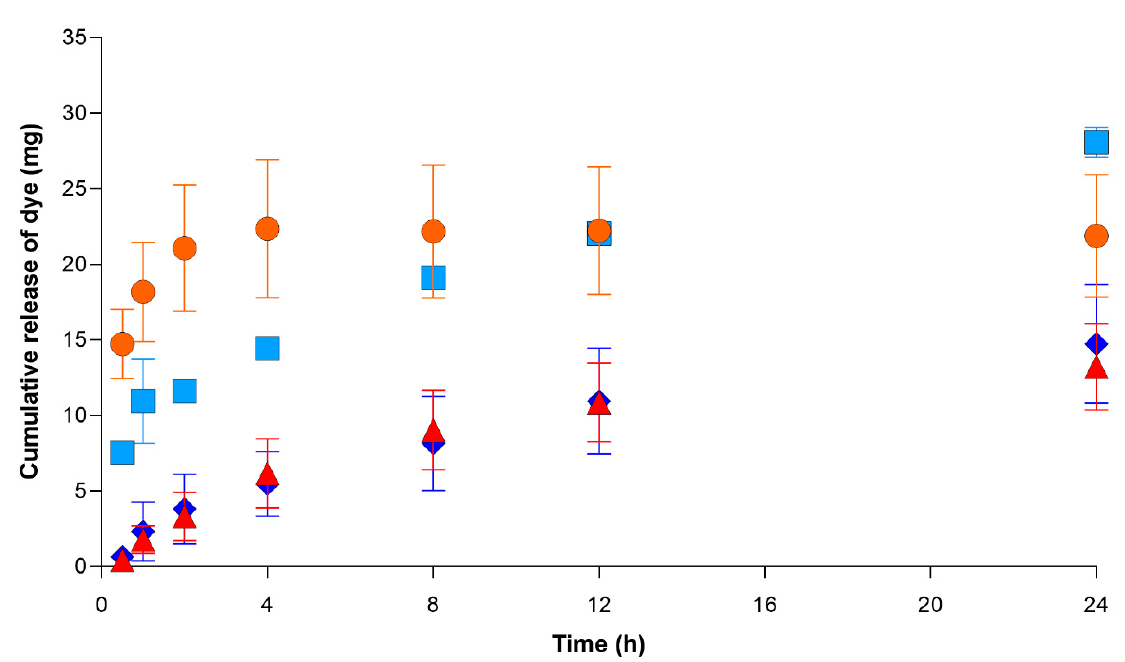
Figure 3. Release of red dye (mg) over 24 h from (  ) etafilcon A in a vial, (  ) senofilcon A in a vial, ( ▲ ) etafilcon A on the eye model, and (  ) senofilcon A on the eye model (n = 3). ) etafilcon A on the The total amount of dye absorbed was 47.8 ± 2.7 mg for etafilcon A and 22.4 ± 2.0 mg for senofilcon A. The percentage release of the dye released from the lenses is shown in Figure 4. In both the vial and the eye model, the total percentage of drugs released for etafilcon A was significantly higher than that for senofilcon A ( p < 0.05). In the vial, there release within the first 4 h. In contrast, the release was more gradual for senofilcon A over